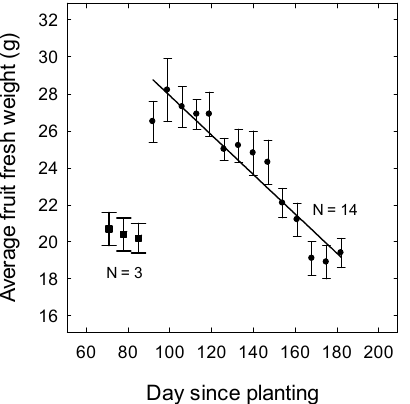
Figure 2. Seasonal changes in average fruit fresh weight (marketable fruit weighing at least 12 g) (AFWT) in strawberries in Queensland. Data are the means ( ± SE or standard error) of five cultivars with six replicates for each cultivar. Day 1 was the date of planting on 29 April and Day 182 was the last harvest on 28 October ( n = 17). For the last 14 harvests, AFWT (g) = Intercept—0.107 × Day ( p < 0.001, R 2 = 0.89). Average fruit fresh weight was low for the first three harvests (not included in regression).